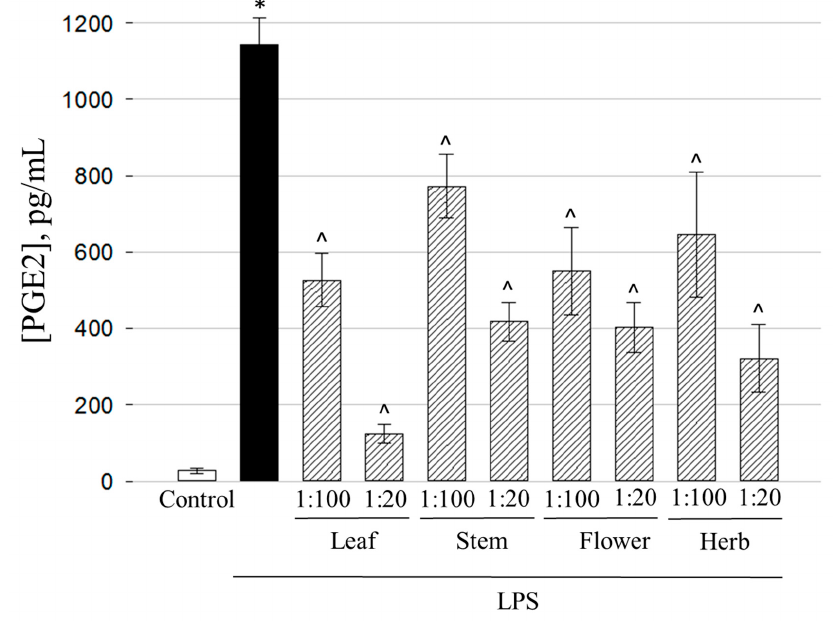
Figure 8. The effect of extracts obtained from different E. ciliata parts on LPS-induced